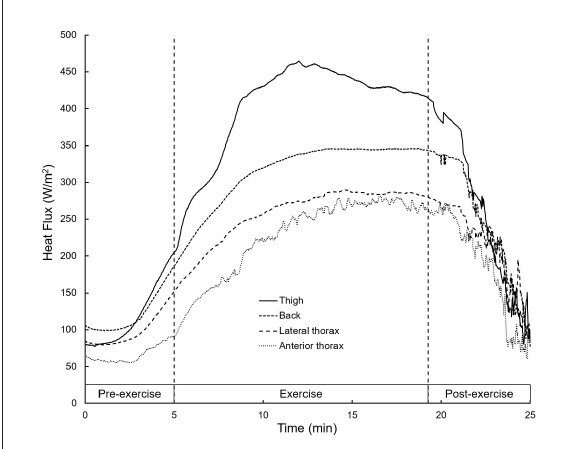
FIGURE1 Mean heat flux measured at different body parts before, during and after exercise. Dashed lines mark the start and the end of the skiing bout.